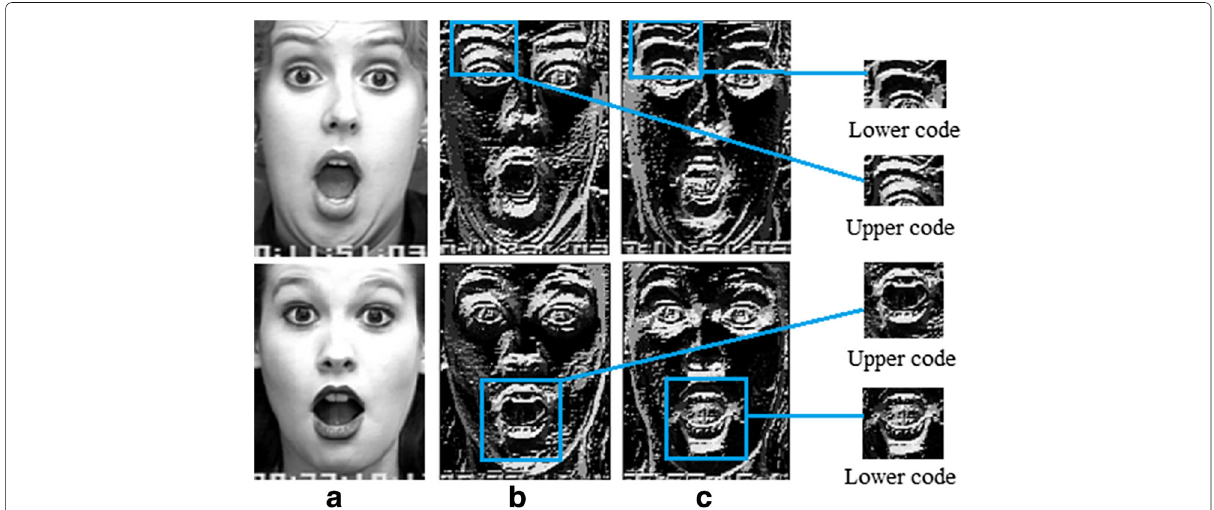
Fig. 11 DTCTH-coded image. a Input image. b Upper code. c Lower code